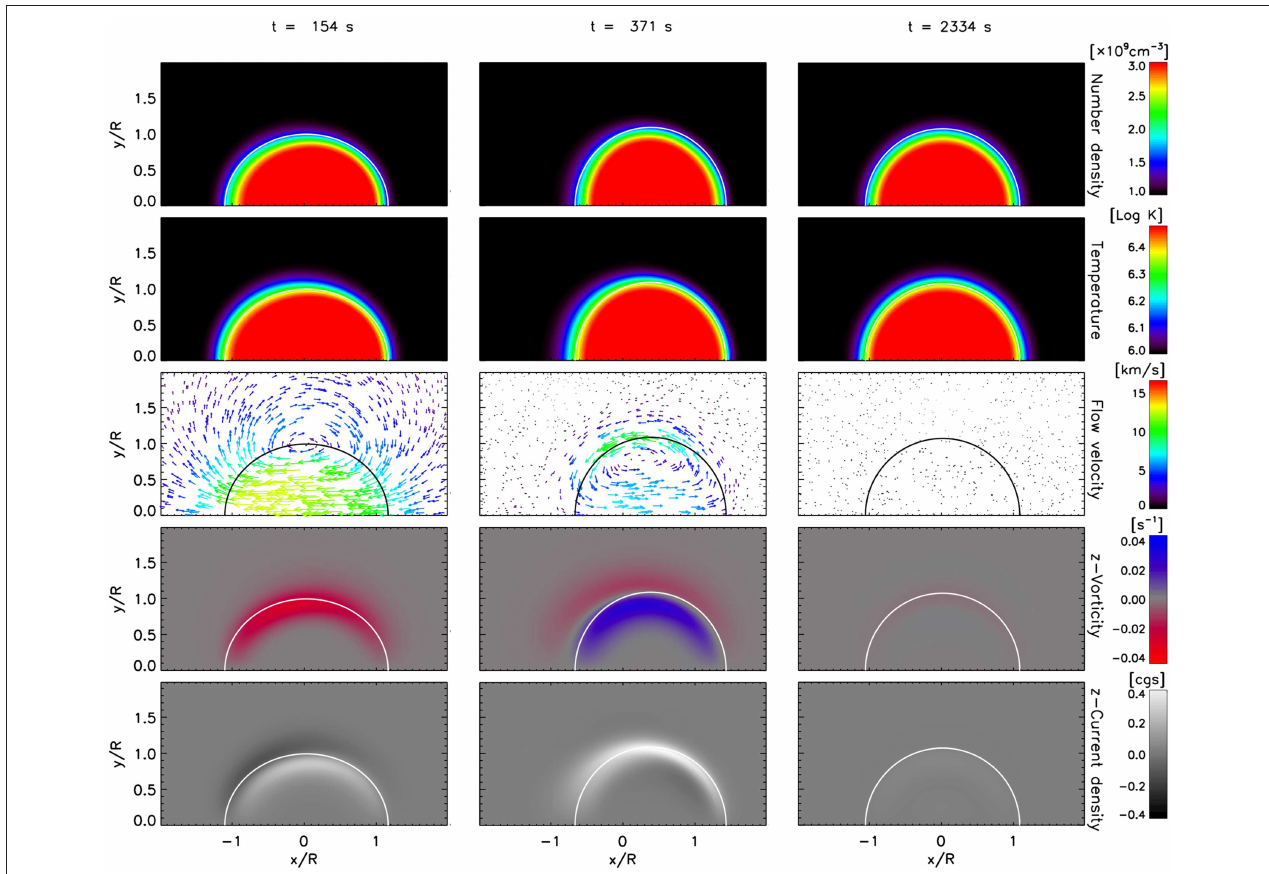
Figure 1 are shown. See also the accompanying movie in the Supplementary Material